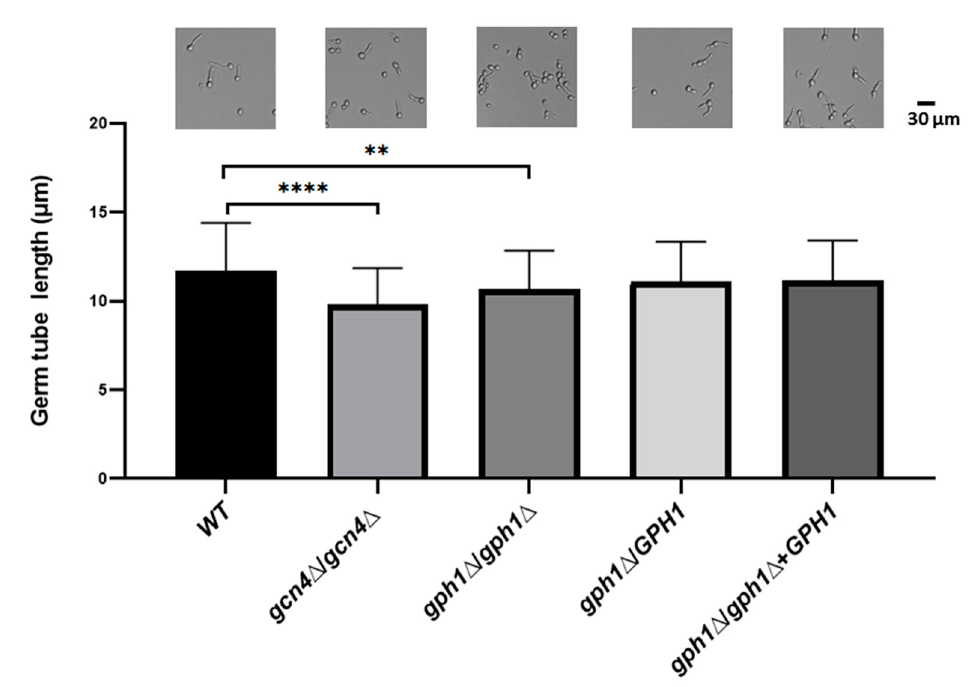
Figure 3. GPH1 acts positively in germ tube formation in C. albicans . The exponentially cultured strains were subjected to 10% fetal calf serum for 1 h to induce germ tube formation. The length of the germ tube was determined from 20 randomly picked germ tube-cells. The representative monographs were from the differential interference contrast (DIC) (also known as Nomarski) microscopy. The GCN4 null mutant gcn4 Δ / gcn4 Δ , known to reduce germ tube formation under the hyphal induction condition, was used as a control. Statistical analyses were performed by one-way ANOVA, with ** p < 0.01 and **** p < 0.001 as indicated. Representative data from one of the three independent experiments are shown.